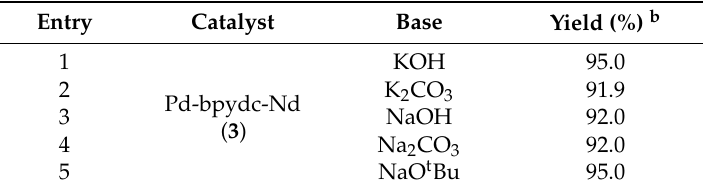
Table 3. Suzuki–Miyaura cross-coupling of 4-bromoanisole with phenylboronic acid in the presence of Pd-bpydc-Nd ( 3 ) when various bases are employed a .